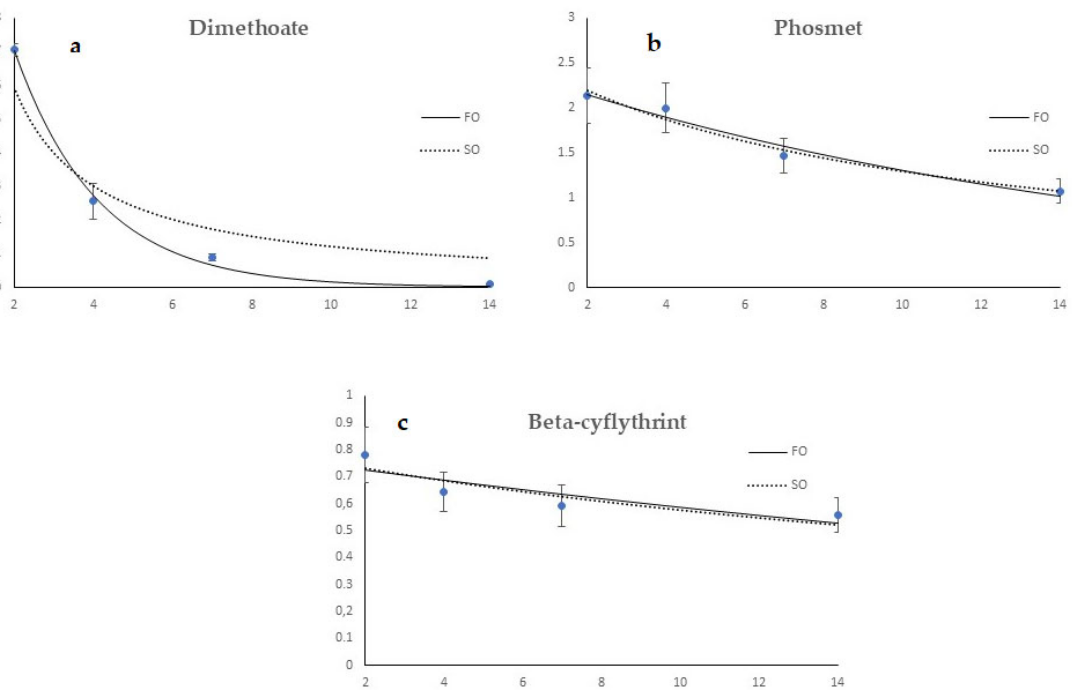
Figure 5. Changes in residual concentrations of dimethoate ( a ), phosmet ( b ) and beta-cyfluthrin ( c ), in olive fruit after determination as dislodgeable foliar residues. Solid and dashed lines indicate the results predicted using first-order (FO) and second-order kinetic models, respectively.